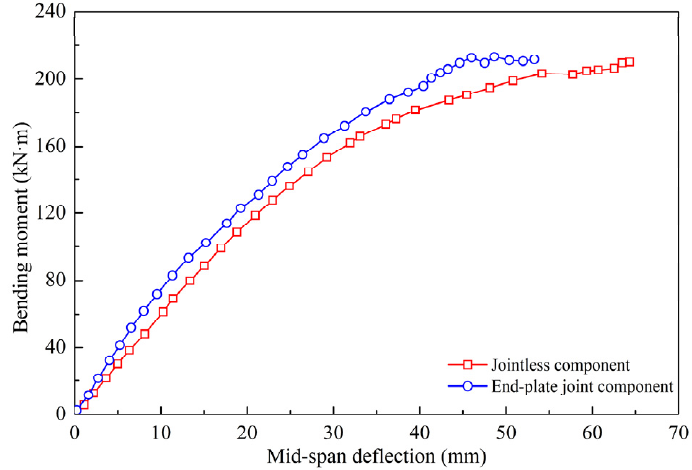
Figure 13. Comparison of bending moment–mid-span deflection displacement relationship curves.